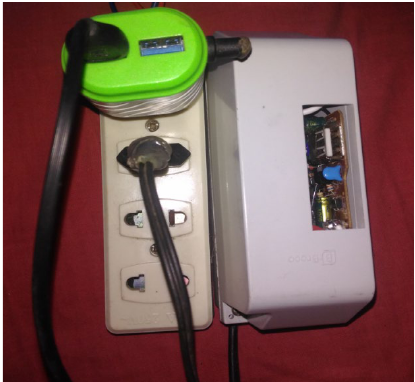
Figure 3. Sensor Data Testing